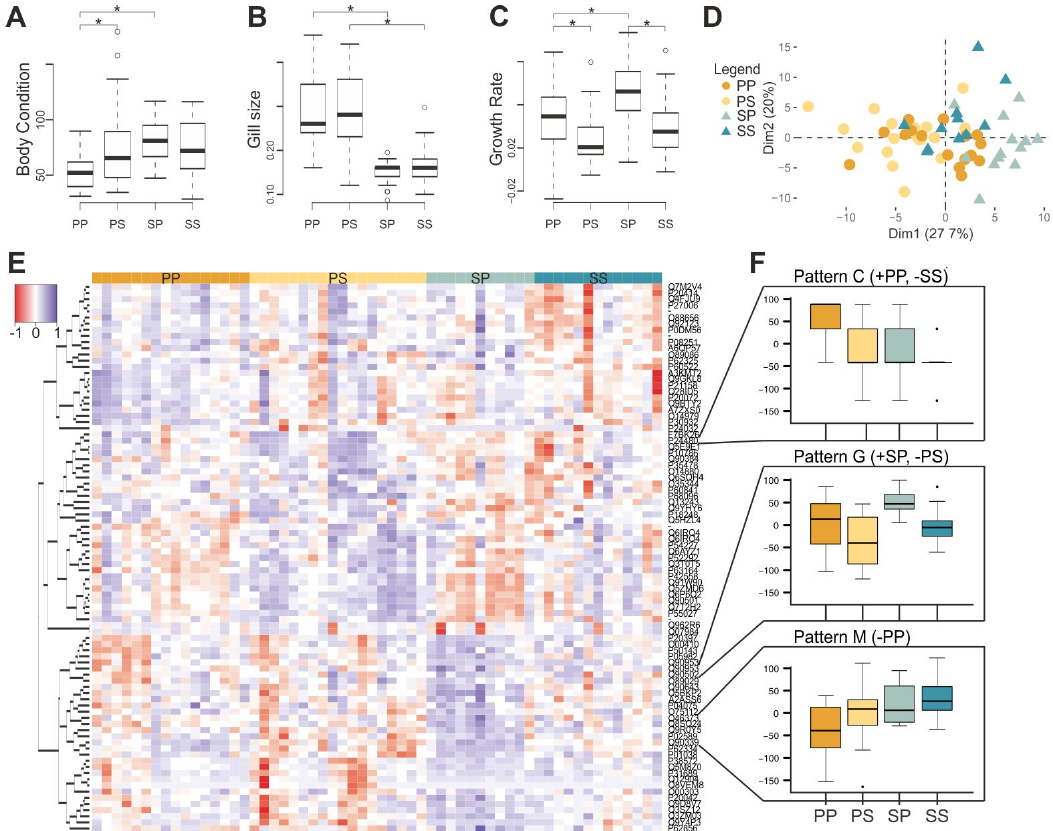
Figure 4. Transfer experiment results. Histograms representing ( A ) body condition index, ( B ) gill size, and ( C ) growth rate of pond individuals (PP), pond individuals transferred to streams (PS), stream individuals transferred to ponds (SP) and stream individuals (SS). ( D ) A posteriori principal component analysis of gene expression data depicting pond-originated (circles), stream-originated individuals (triangles), transferred (lighter), and non-transferred (darker). ( E ) Heat map of the differently expressed transcripts (89) between PP, PS, SP, and SS. ( F ) Expression patterns identified by self-organizing maps analysis based on differently expressed probes (+: Overexpression, − : Underexpression).